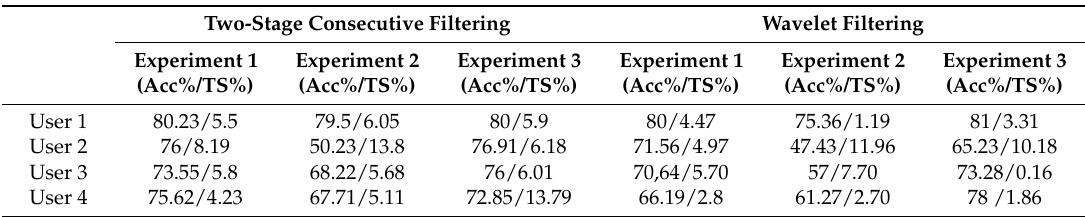
Table 5. Classification performance obtained from IMU sensors: filtering comparison.